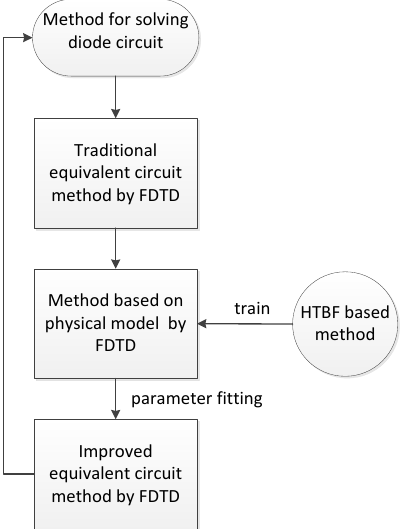
Figure 3. Flow chart of the HTBF base method.